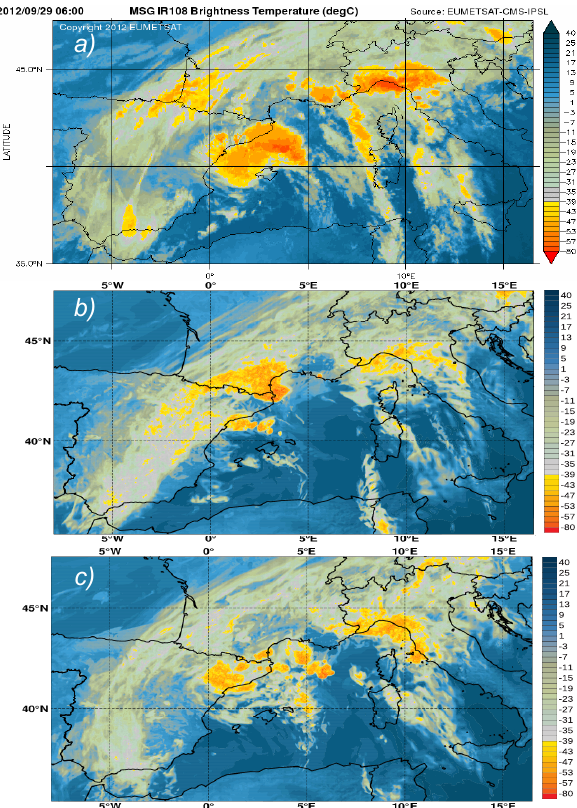
Figure 24. The 24h accumulated precipitation (mm) from 29 September 2012 at 00:00UTC to 30 September at 00:00UTC: observations (a) , 48h AROME-WMED forecast (b) and 24h AROME-WMED forecast (c) .